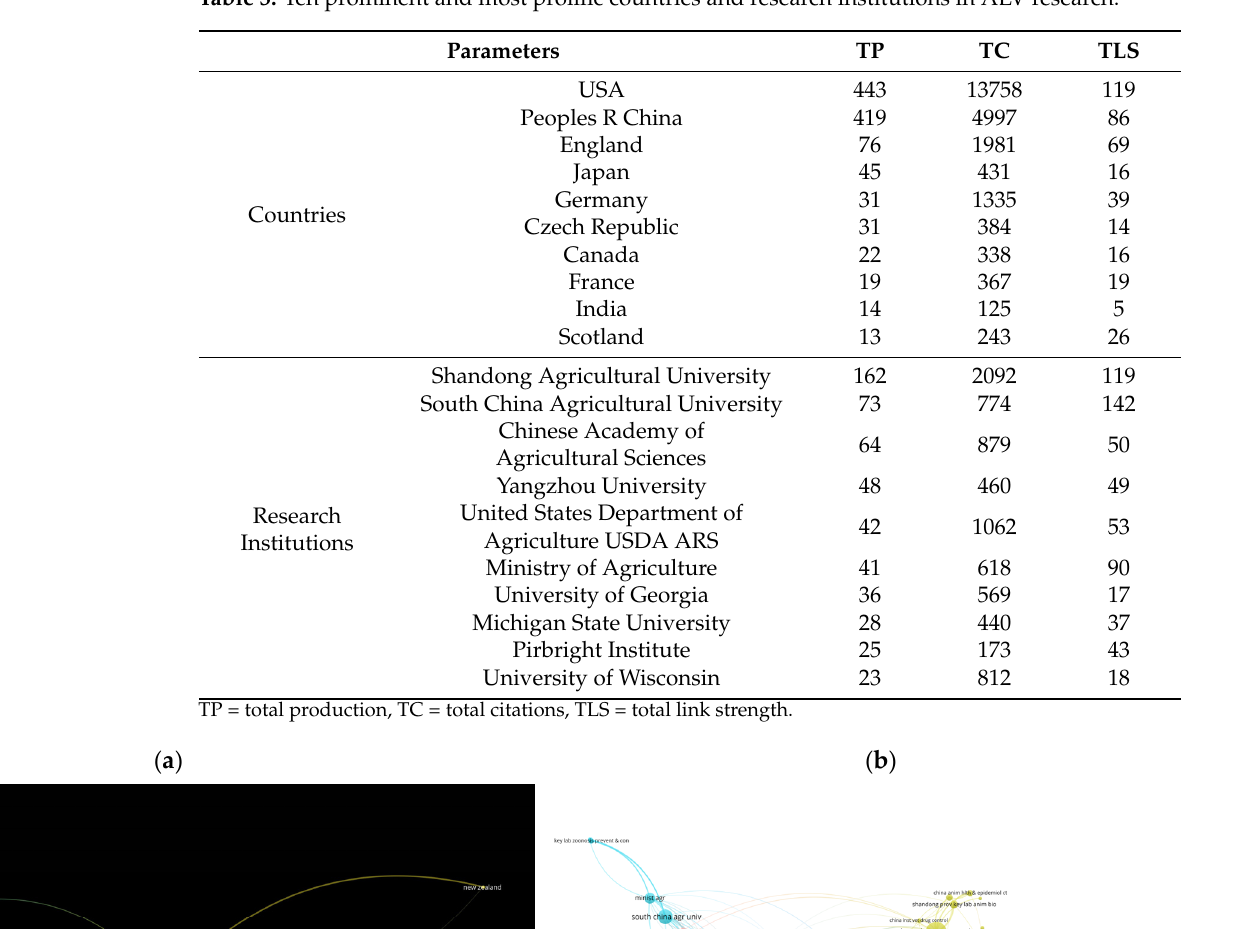
Table 3. Ten prominent and most prolific countries and research institutions in ALV research.